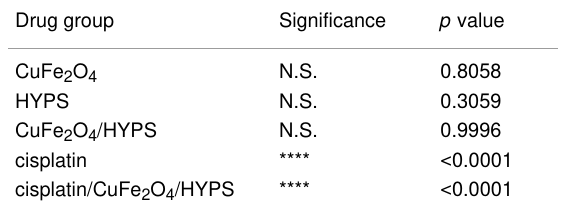
Table 3: Significance and p values of experimental groups using the highest dose. * p < 0.05; ** p < 0.01; *** p < 0.001; **** p < 0.0001 versus control. N.S. indicates non-significant.